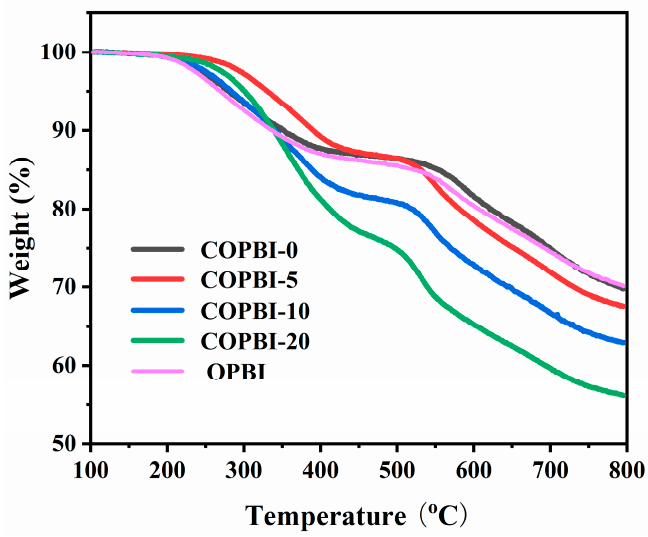
Figure 5. Thermogravimetric curves of OPBI and COPBI membranes.